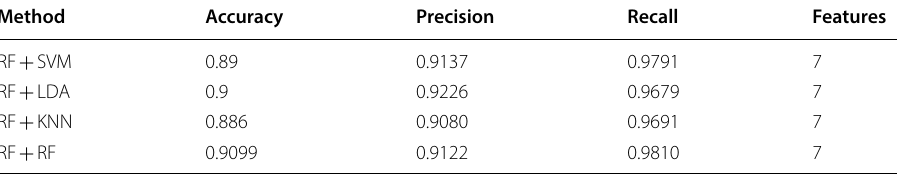
Table 9 Statistics by the class of different classifiers with bank marketing dataset